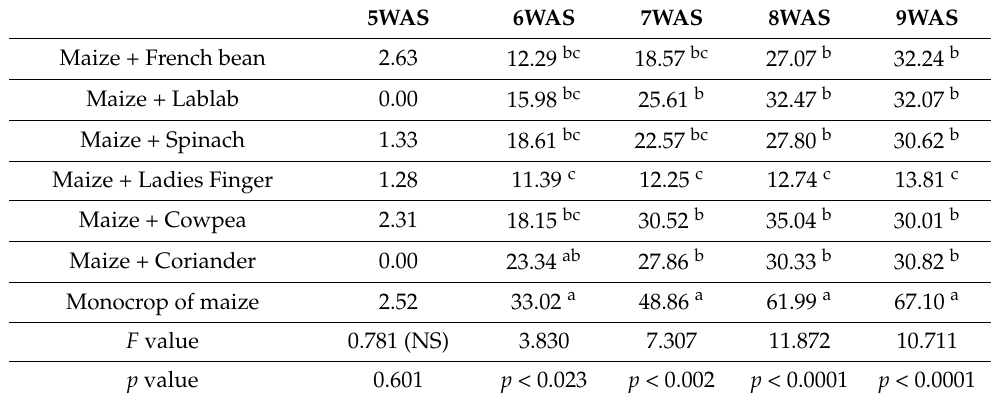
Table 6. Effect of vegetable intercropping on maize infestation by Fall Armyworm at different weeks after sowing